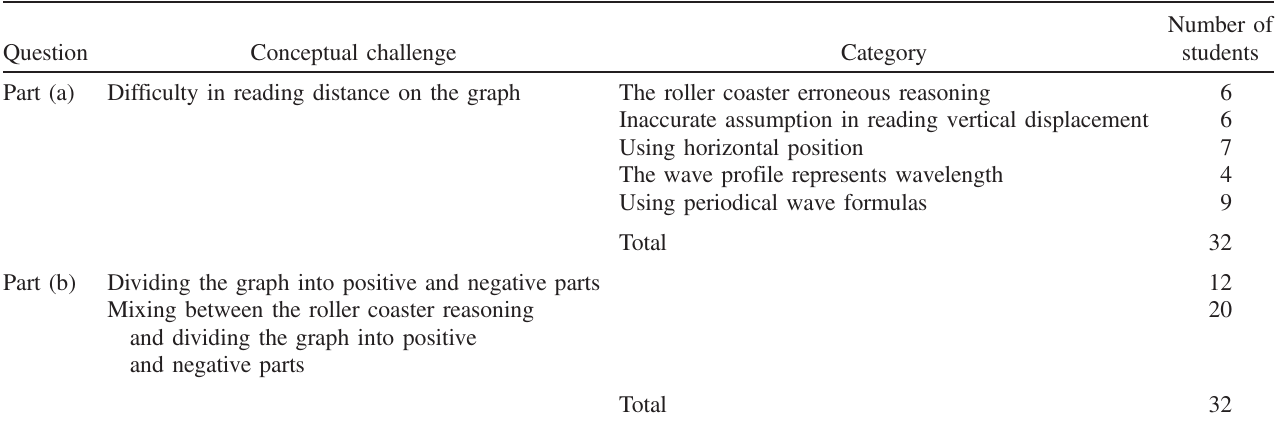
TABLE I. Students ’ conceptual challenges in phase